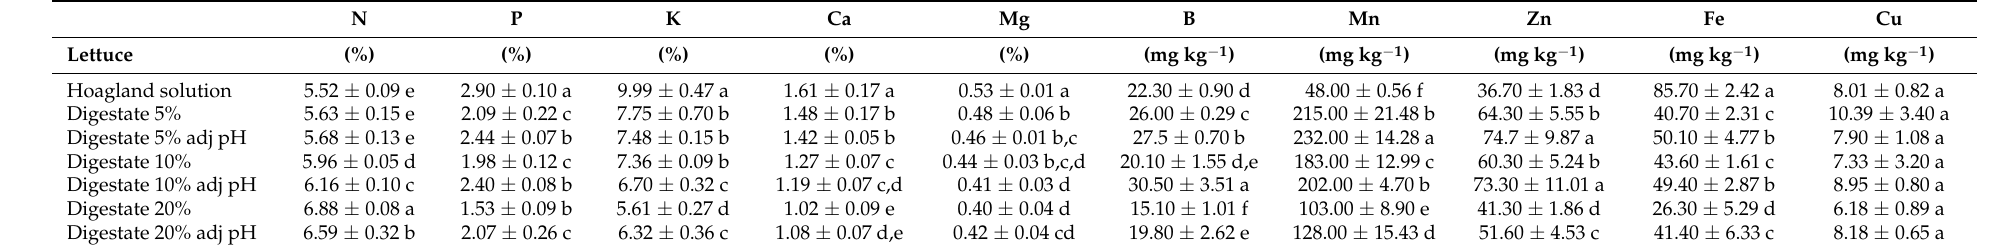
Table 3. Plant nutrient concentrations of baby lettuce grown in different digestate conditions (Hoagland solution 100% and digestate 5, 10, and 20%). Values followed by different letters present statistically significant differences ( p <